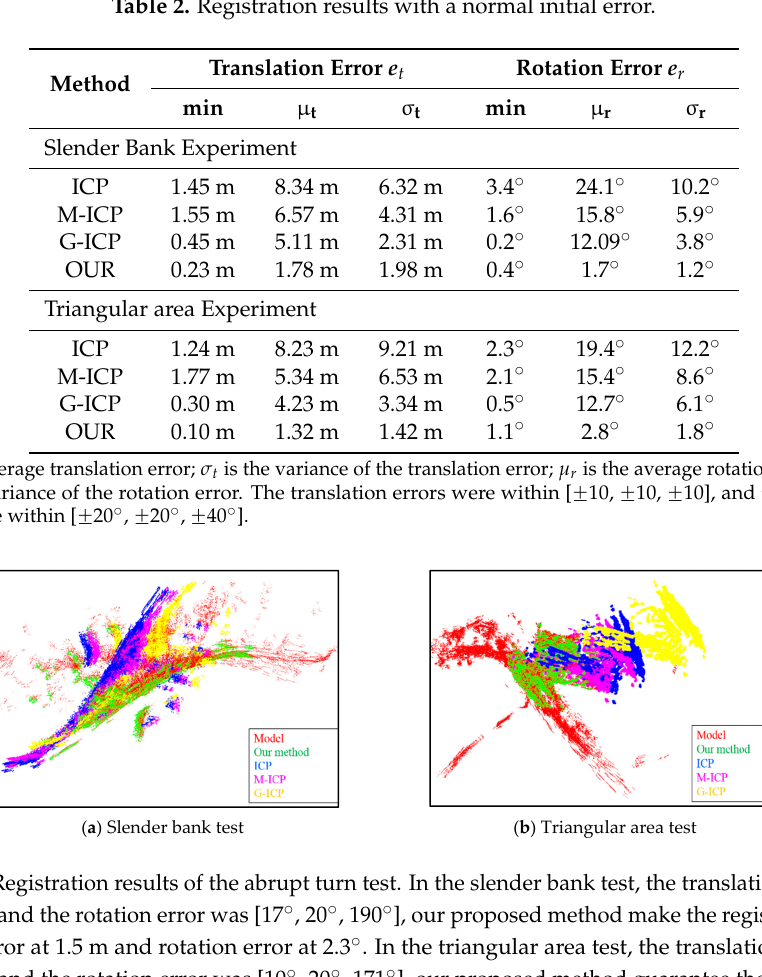
Table 2. Registration results with a normal initial error.